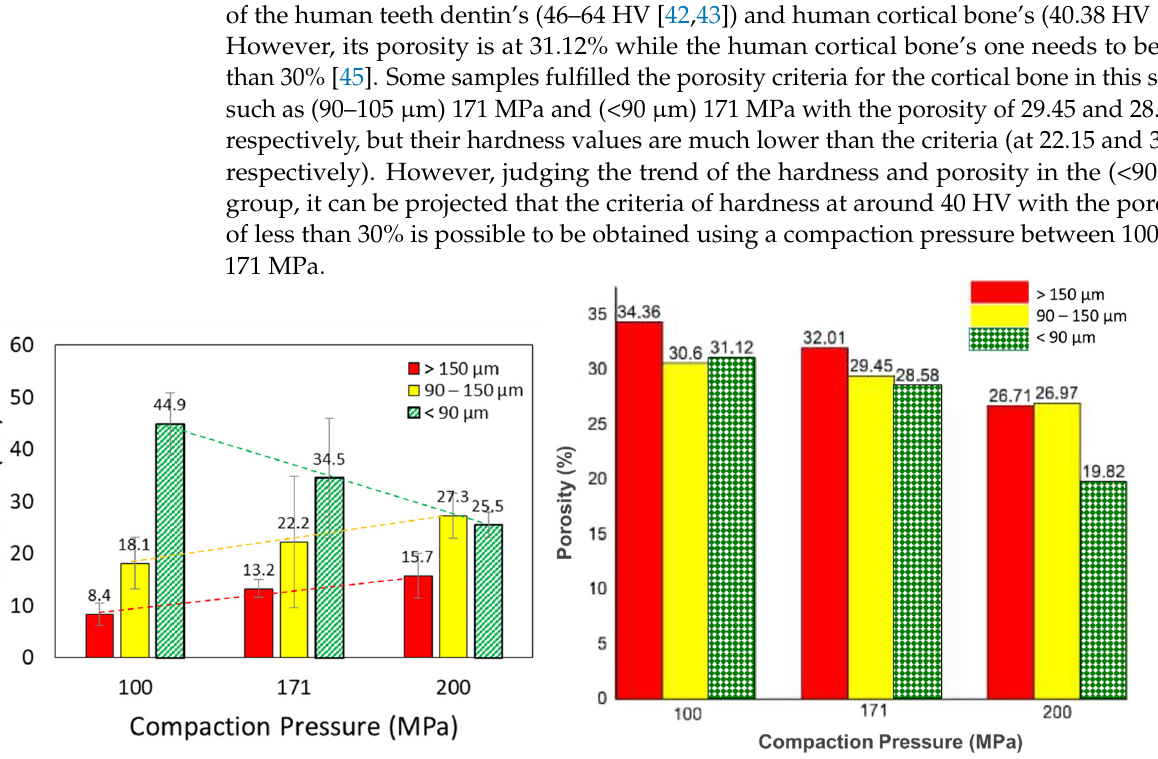
Figure 4. XRD of the hydroxyapatite composite made by compaction pressure of 100 MPa and Al particle size of ( a ) <90 and ( b ) >150 µ m. This indicates that in the case of smaller Al particle size (<90 µ m), the oxidation of the Al metal into alumina is easier compared to those of spinel. On the other hand, for bigger Al particle size (>150 µ m), the oxidation of Al metal is more favorable toward the spinel formation, as shown by the presence of Al and spinel peaks but in the absence of alumina (Figure 4b). Alumina is a known bio-ceramic for medical applications, such as in dental applications (i.e., orthodontic brackets, dental implants, fixed prostheses, and bone ce- ment filler) [46], or joint replacements [47]. The presence of alumina has also been reported to increase the hardness of a composite [48]. The presence of alumina might be responsible for the increase of the hardness observed from 8.36 to 44.92 HV for >150 and <90 µ m, re- spectively. Another possibility of the increase of hardness is coming from the increase of crystallinity of the HAp [49]. The HAp peak at (112) in the >150 µ m sample is relatively taller compared to the <90 µ m one, indicating its higher crystallinity. The higher the HAp crystallinity instead produces a smaller hardness value in this study, opposite to those reported by Ref. [49]. This indicates that the effect of Al 2 O 3 formation on the composite’s hardness is more dominant.